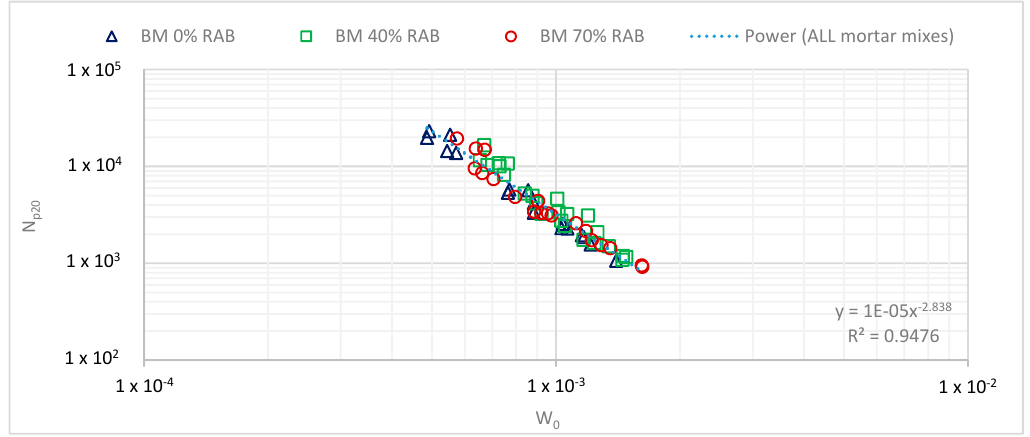
Figure 11. Fatigue resistance of mortars, based on the DER approach (N p20 ).